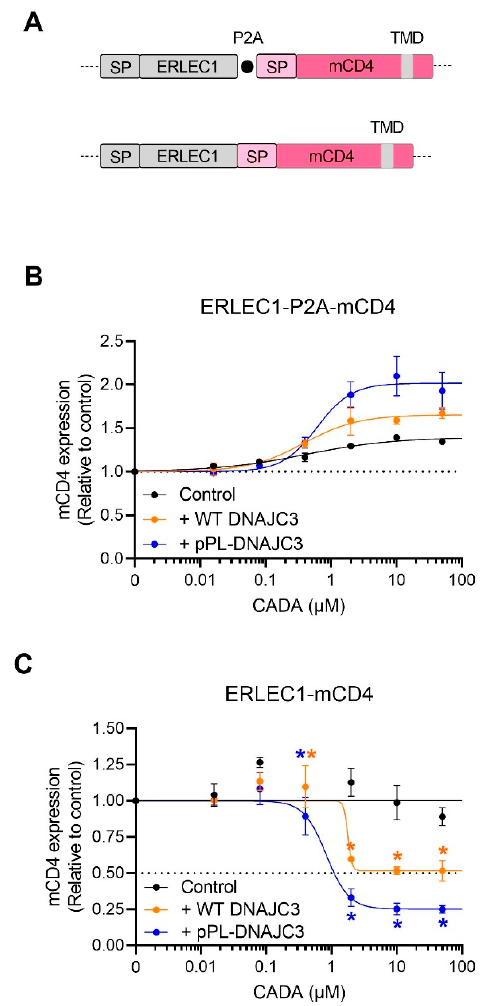
Figure 6. DNAJC3 affects the expression of a CADA-resistant protein differentially depending on the nature of the transcript. ( A ) Representation of the ERLEC1-mCD4 chimaeric constructs. The constructs expressed intracellular ERLEC1 and cell surface mCD4 that was anchored in the plasma membrane via its transmembrane domain. In the first construct, the two proteins were separated by a P2A sequence, whereas, in the second construct, the SP of mCD4 was directly fused to the C-terminus of ERLEC1. ( B ) Four-parameter concentration–response curves for the CADA of mCD4 that was cloned in the ERLEC1-P2A-mCD4 backbone as shown in ( A ). HEK293T cells were transiently transfected with ERLEC1-P2A-mCD4 plasmid DNA, or co-transfected with ERLEC1-P2A-mCD4 plasmid DNA and WT DNAJC3 or pPL-DNAJC3 and incubated with different CADA concentrations for 24 h. Transfected ERLEC1-P2A-mCD4 plasmid DNA was equal to the transfected ERLEC1-P2A-mCD4 plasmid DNA in the co-transfected conditions. Cells were fixed, permeabilized and stained with an anti-mCD4 antibody. Total levels of mCD4 in CADA-treated samples were normalised to the DMSO control (set at 1.0). Curves were fitted to data from two replicate experiments. Values are mean ± SD; n = 2. ( C ) Similar as in ( B ) but for the second construct without the P2A sequence. Curves were fitted to data from three replicate experiments. Values are mean ± SD; n = 3, except for the 0.08 µ M CADA samples of control and WT DNAJC3 for which n = 2. Statistical analysis (multiple unpaired t -tests) showed significantly decreased expression of mCD4 when co-expressed with WT DNAJC3 and pPL-DNAJC3 as compared to the control. Of note, the values of 0.4 µ M CADA for the ERLEC1-mCD4 construct only (black dots) have been removed to plot the black curve. These values are represented separately in Supplementary Figure S5. mCD4: mouse CD4; ERLEC1: endoplasmic reticulum lectin 1; CADA: cyclotriazadisulfonamide; HEK293T: human embryonic kidney 293T cells; pPL: pre-prolactin; DNAJC3: DnaJ homolog subfamily C member 3. (* = p <